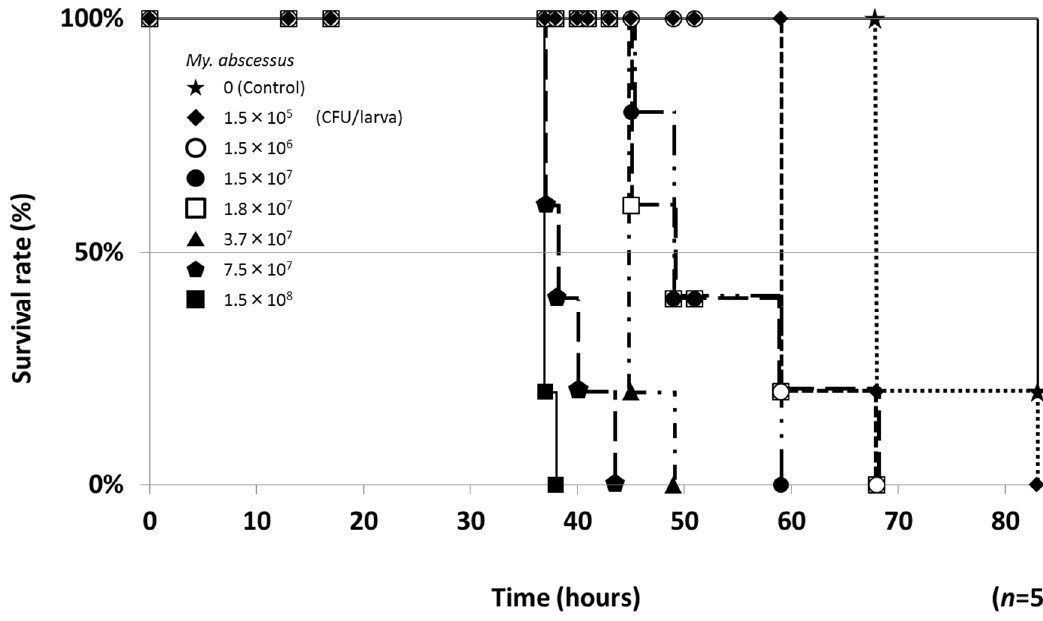
Figure 2. Silkworm-killing ability of My. abscessus . A suspension of My. abscessus ATCC19977 strain was diluted to the indicated cell number and injected into the silkworm hemolymph. Infected silkworms were incubated at 37 °C. The number of surviving silkworms was counted until 83 h after the injection. Experiments were performed two times and reproducible data were observed.